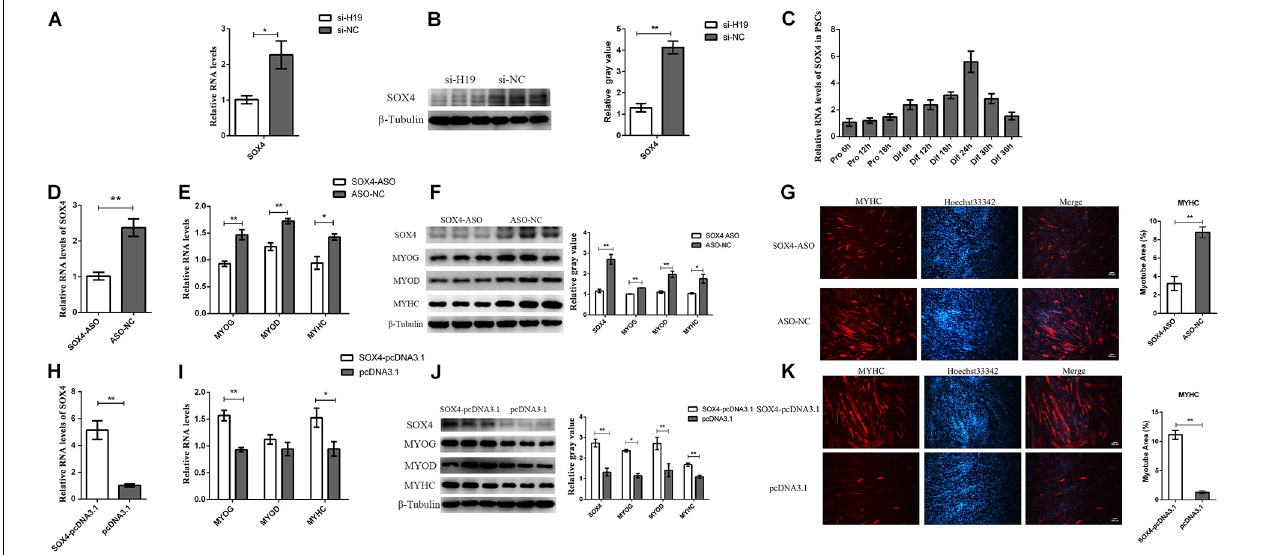
FIGURE 4 | Functional research of the SOX4 gene. (A) Real-time PCR analysis of SOX4 after the knockdown of H19. (B) The protein level of SOX4 after the knockdown of H19. (C) Real-time PCR analysis of SOX4 expression in PSCs during the period of proliferation and differentiation. There is a 6-h interval between each period. (D) The efficiency of SOX4 ASO. (E) Interference of SOX4 decreased the mRNA levels of MYOG, MYOD, and MYHC. (F) Knockdown of SOX4 decreased the protein levels of MYOG, MYOD, and MYHC. The gray level of WB was calculated by Image J software. (G) Representative photographs of MYHC immunofluorescence staining in PSCs differentiated for 24 h showing that SOX4 knockdown significantly decreased the MYHC protein expression level. The myotube area was calculated by Image J software. Each experiment had three biological replicates. (H) Real-time PCR analysis of SOX4 expression in PSCs transfected with control vector or SOX4-pcDNA3.1 vector. (I) Overexpression of SOX4 increased the mRNA levels of MYOG and MYHC but did not affect MYOD expression. (J) Overexpression of SOX4 significantly promoted the protein levels of MYOG, MYOD, and MYHC. (K) Representative photographs of MYHC immunofluorescence staining in PSCs differentiated for 24 h showing that SOX4 overexpression significantly increased the MYHC protein expression level. (G) and (K) were two separate experiments, and the cell seeding densities were different. Mean values ± SEM, n = 3. * p < 0.05, ** p <